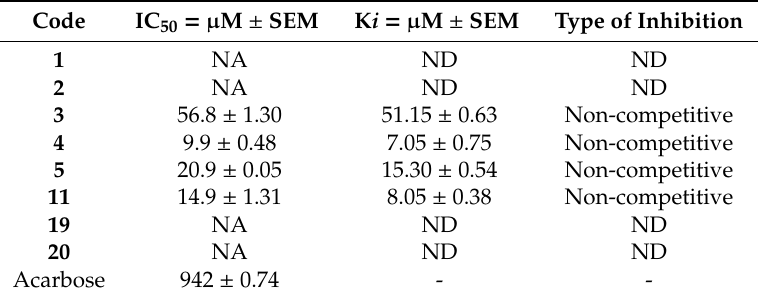
Table 1. α -Glucosidase inhibition of active constituents from B. elongata